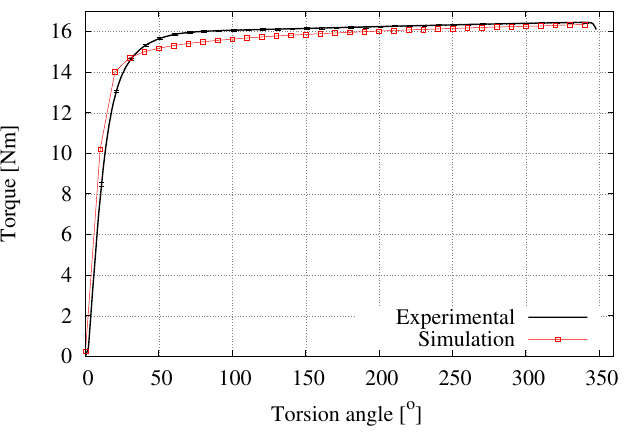
Figure 15. Average experimental and numerical results for the torque as a function of the torsion angle, NRMSD = 2.26%.